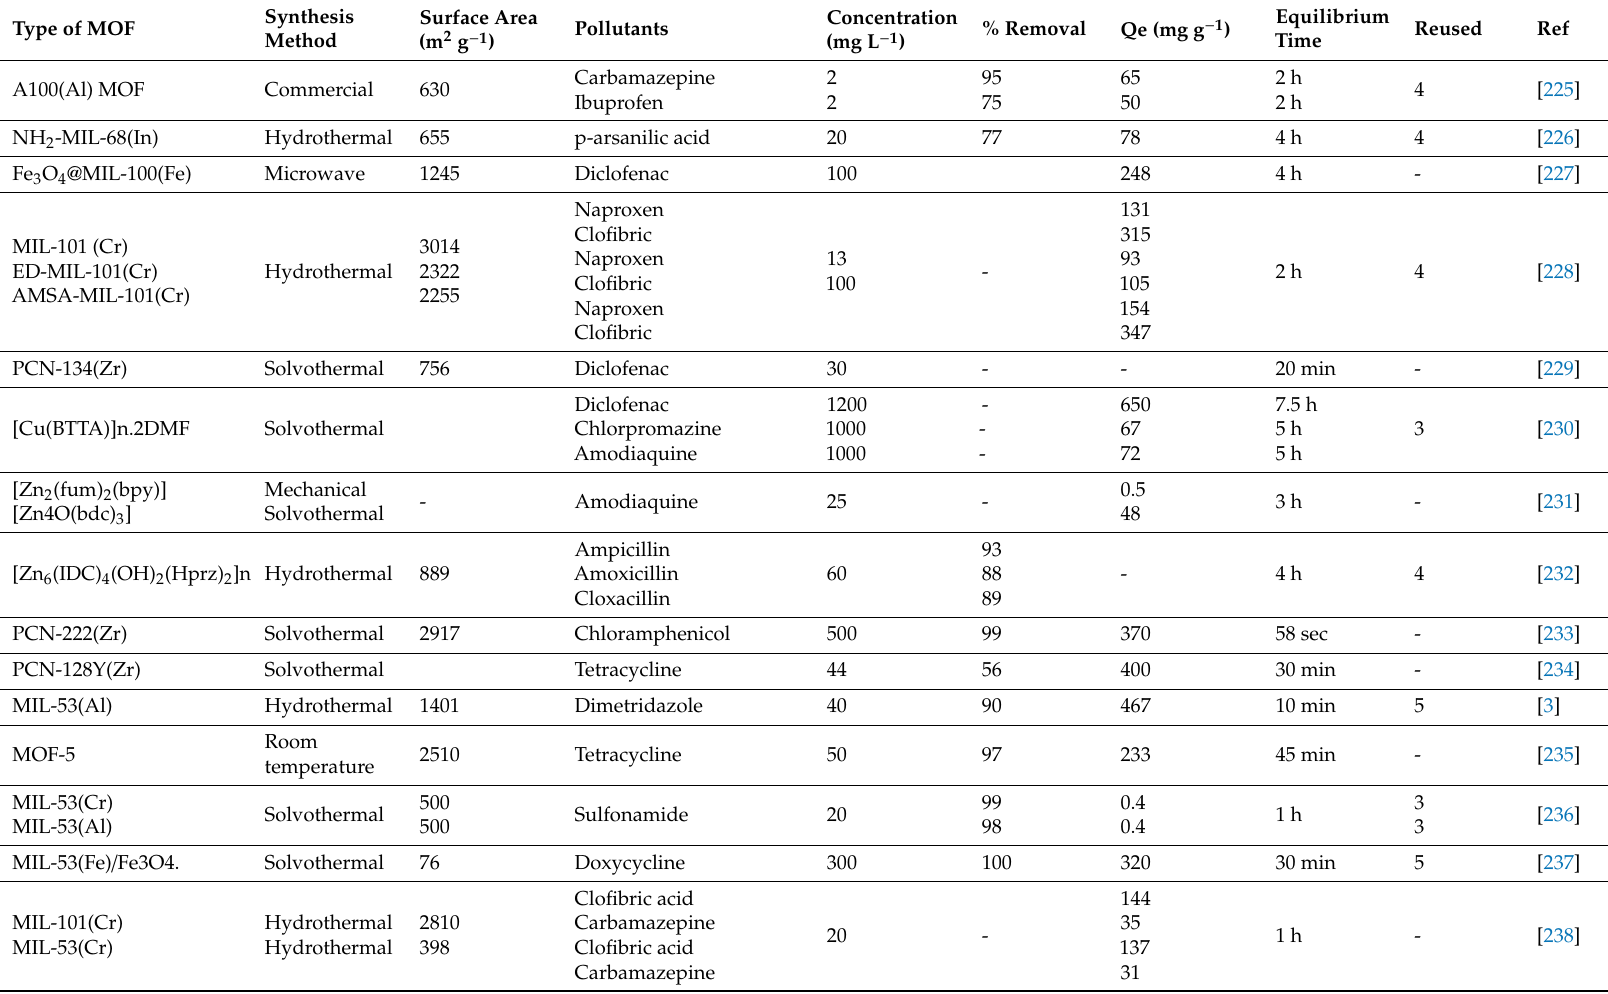
Table 5. Adsorptions of PPCPs onto MOFs and their